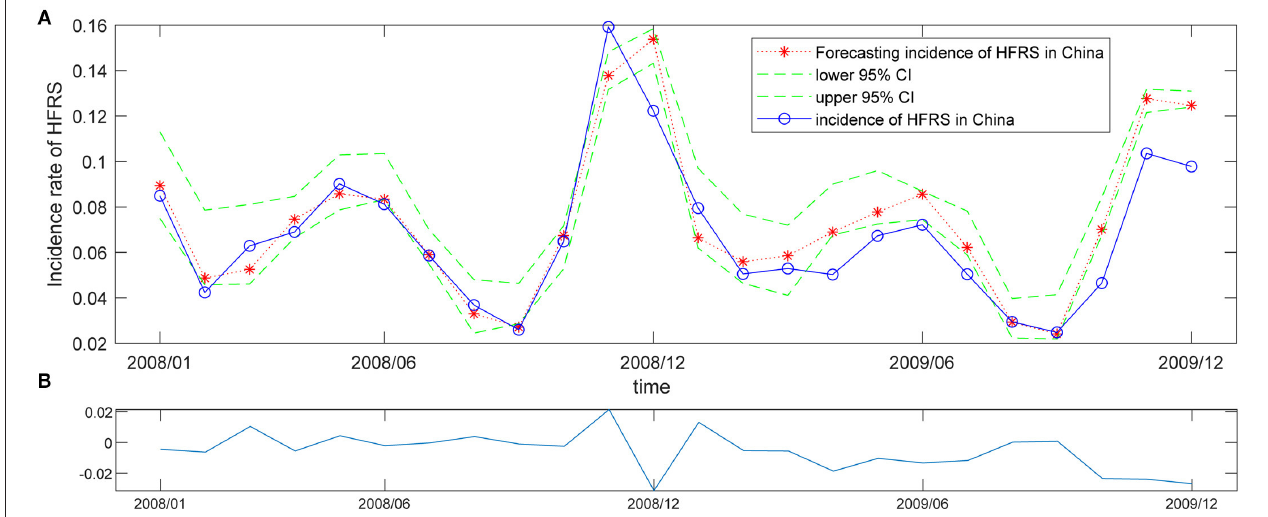
FIGURE 5 | Prediction of HFRS incidence with the WNN model of 12-6-1. (A) Forecasted value of HFRS incidence according to the WNN model of 12-6-1. The red asterisk and dashed line represent the forecasted counts, the blue solid line represents the observed values, and the green dashed lines above and below the red dashed line from Jan 2008 to Dec 2019 indicate the upper and lower 95% confidence limits (CL), respectively, for the forecasted counts. (B) The absolute error of this WNN model in the training